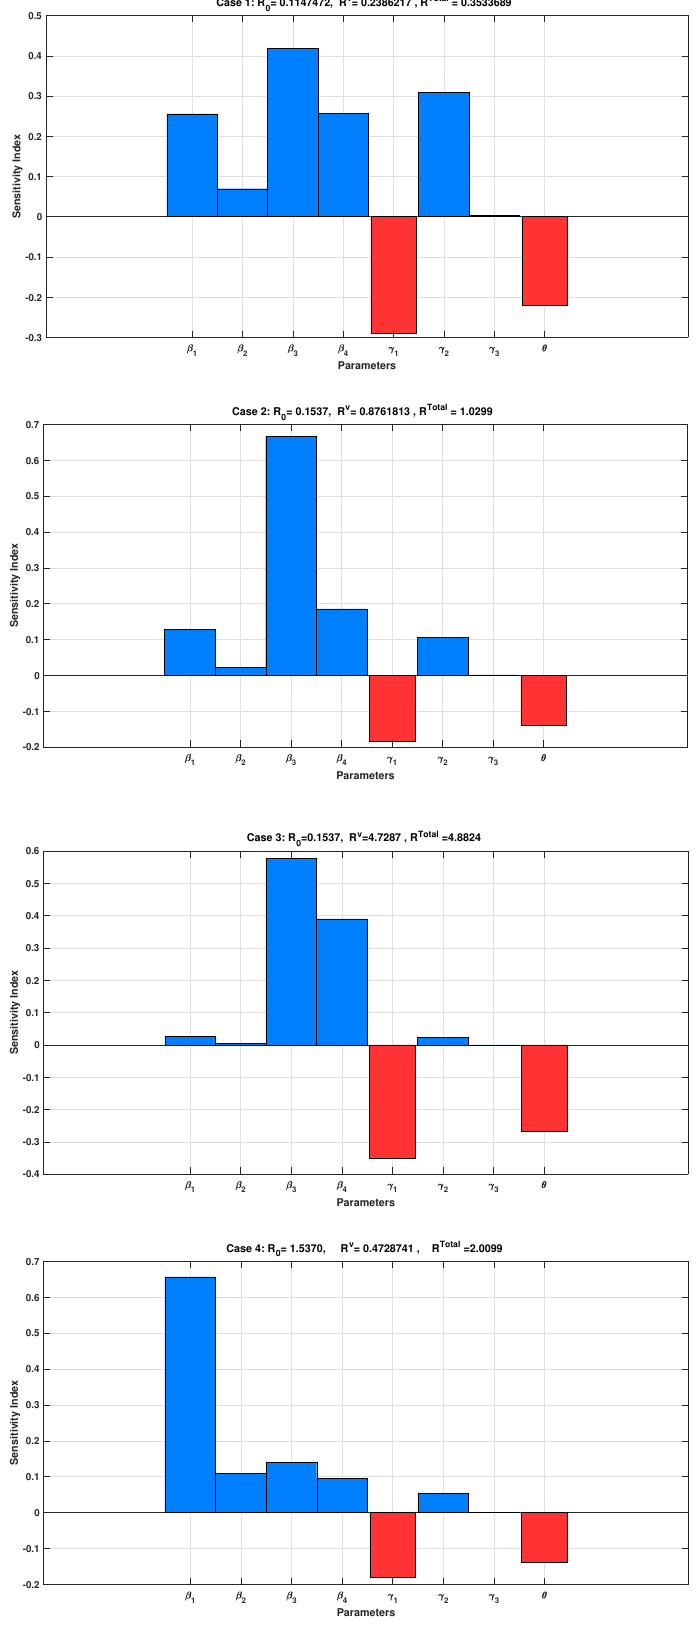
Figure 3. Scenarios of R 0 Total sensitivity respecting the